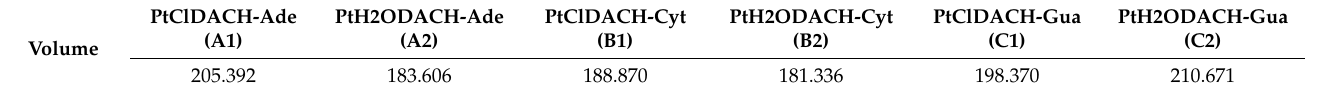
Table 5. Molar volume (cm 3 /mol) of selected complexes computed at the MN15/def2-TZVP level of theory. Molecular structures of the complexes are shown in Figure